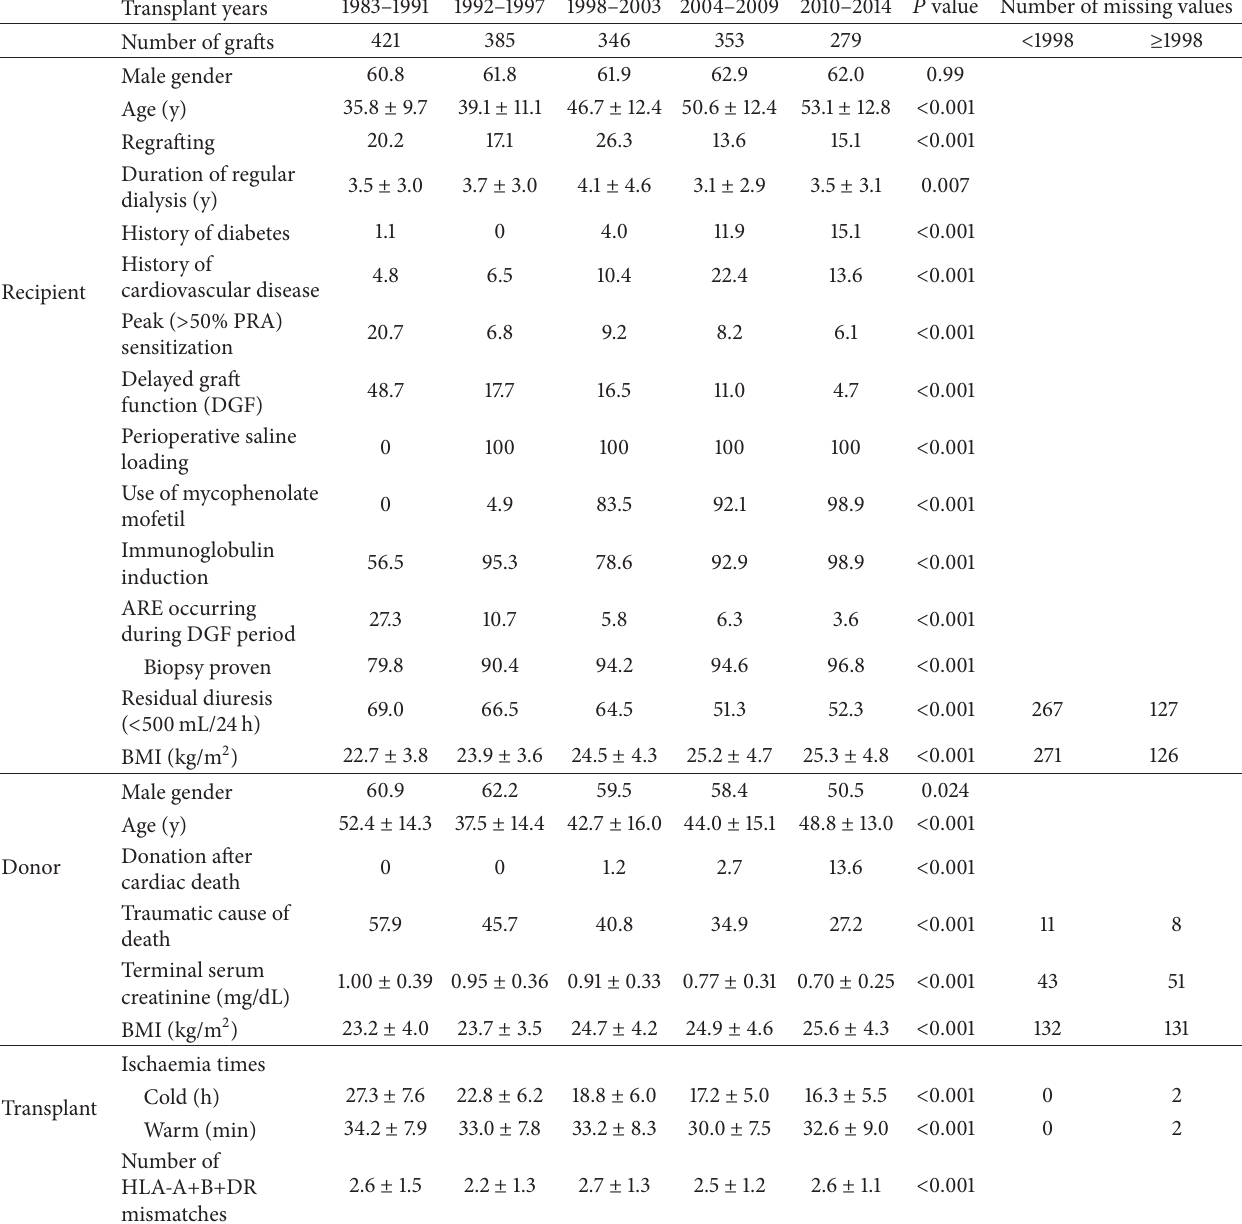
Table 1: Time evolution of demographic characteristics in 1784 transplantations performed from 1983 to